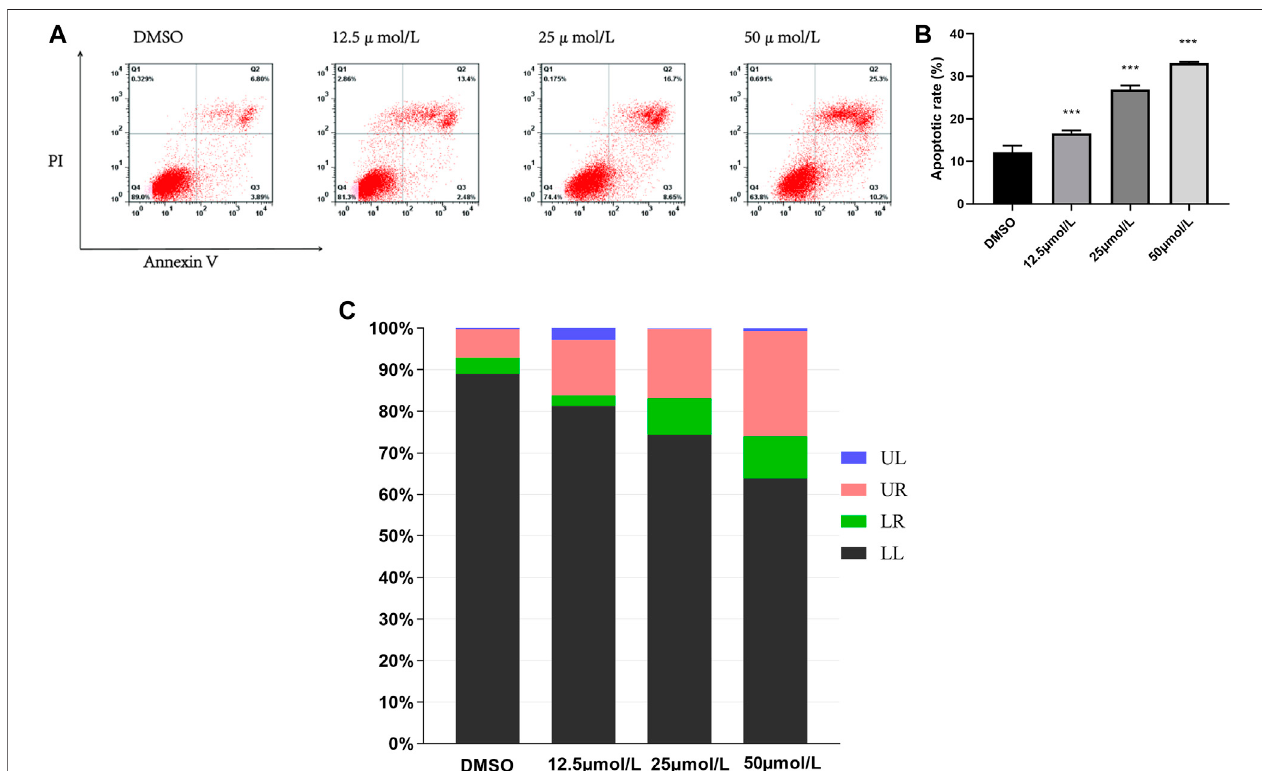
FIGURE 2 | Effect of RPDPD on the apoptosis of HeLa cell. (A) FITC/PI double staining analysis of apoptosis induction of HeLa cells after RPDPD treatment for 48 h.ComparedwiththeDMSOcontrolgroup,** p < 0.01and*** p < 0.001(x±s, n =3). (B,C) Livingcells(LL),earlyapoptoticcells(LR),lateapoptotic(UR),andnecrotic cell/fragment (UL) rate of HeLa were